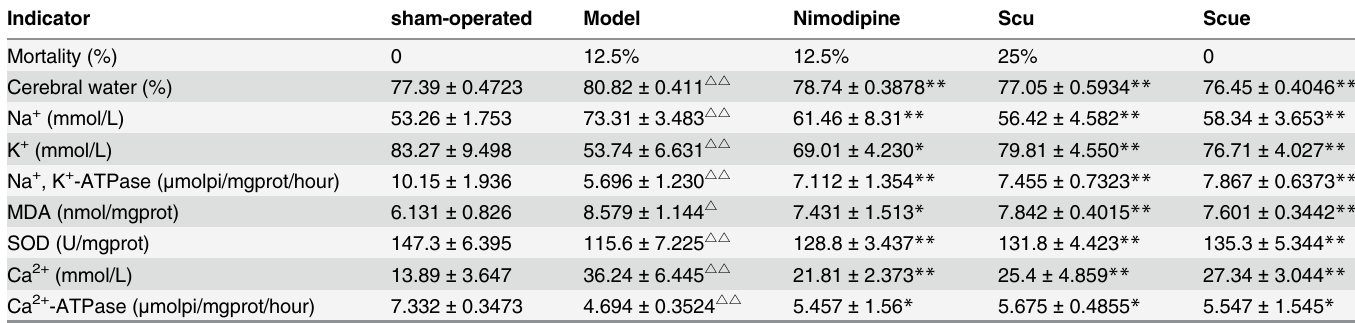
Table 1. Biochemical indicator levels in hippocampal tissue.